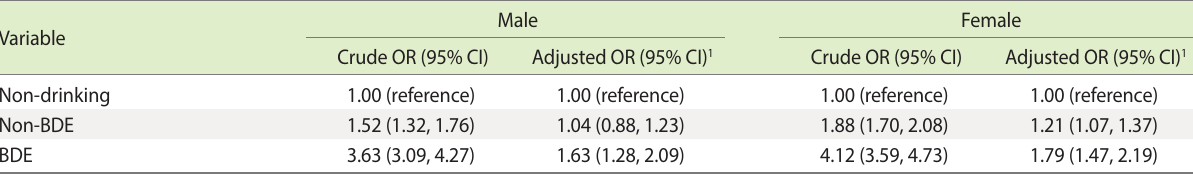
Table 4. Relationship between binge drinking experience (BDE) and suicide attempts Variable